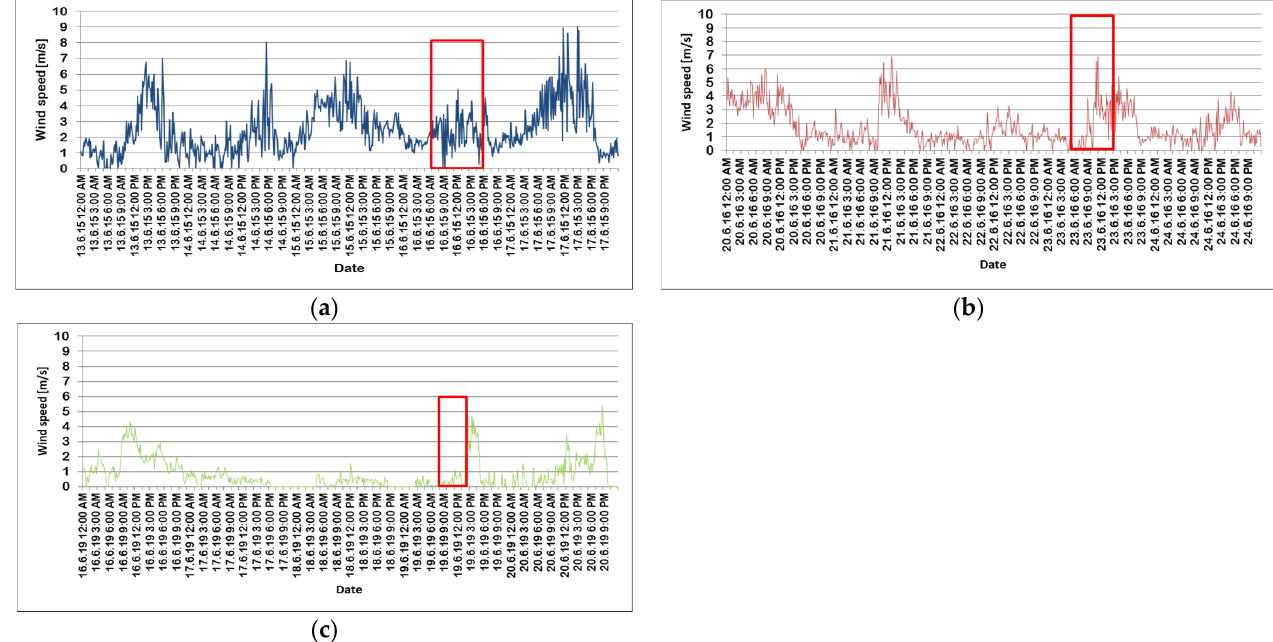
Figure 2. Wind speed course during the period of diatom sampling in the Dehtá ř fishpond: ( a ) 2015, ( b ) 2016, and ( c ) 2019. The particular date and time of sampling are marked by red rectangles.